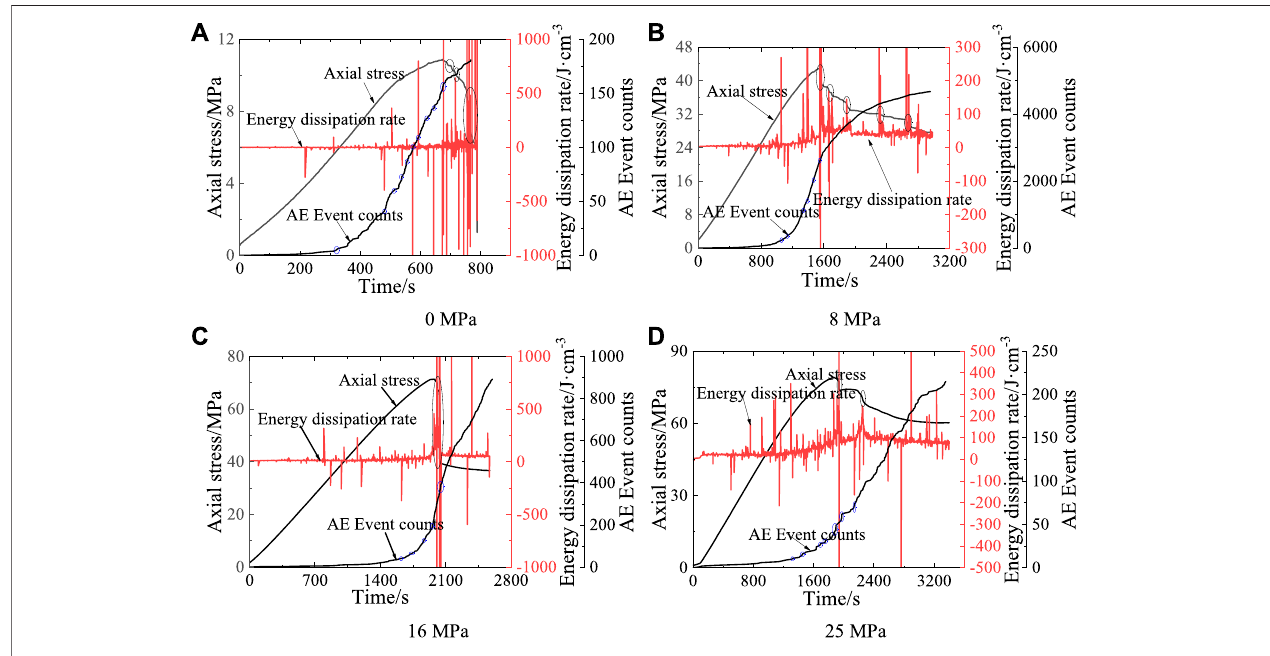
FIGURE 9 | Relationship between energy dissipation rate of coal and rock and the number of AE events. (A) 0 MPa, (B) 8 MPa, (C) 16 MPa, (D) 25 MPa.